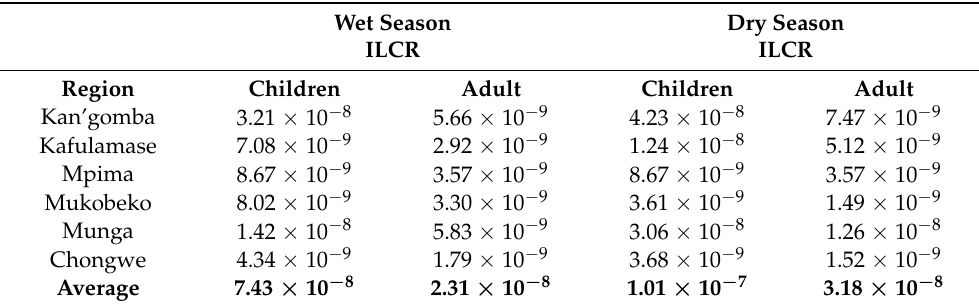
Table 5. Incremental lifetime cancer risk (ILCR) of lead through consumption of cow milk (in children and adults) in the residents of